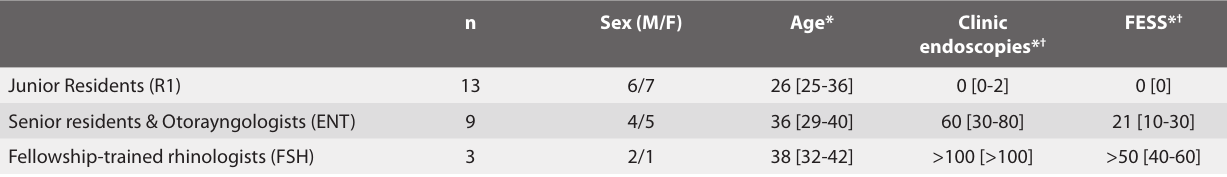
participants.*Median Table 3. Satisfaction survey applied to